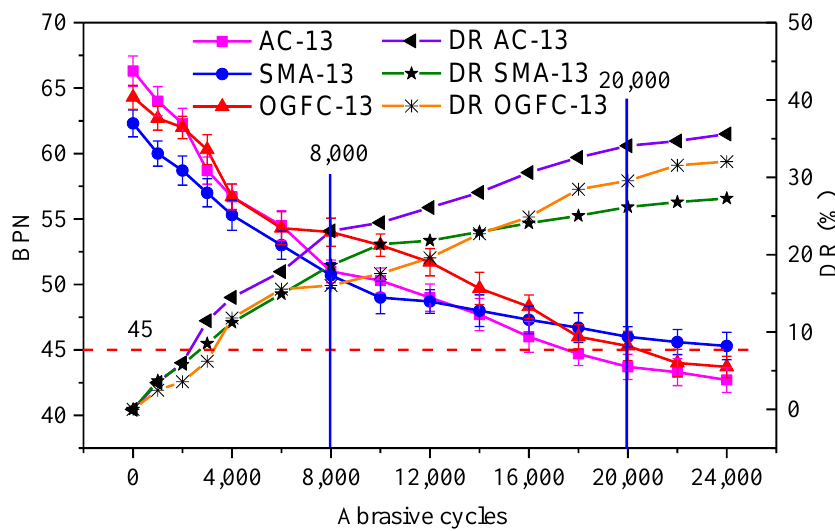
Figure 7. BPN and DR of specimens with different gradations.